Question: Which visualization type does this figure use?
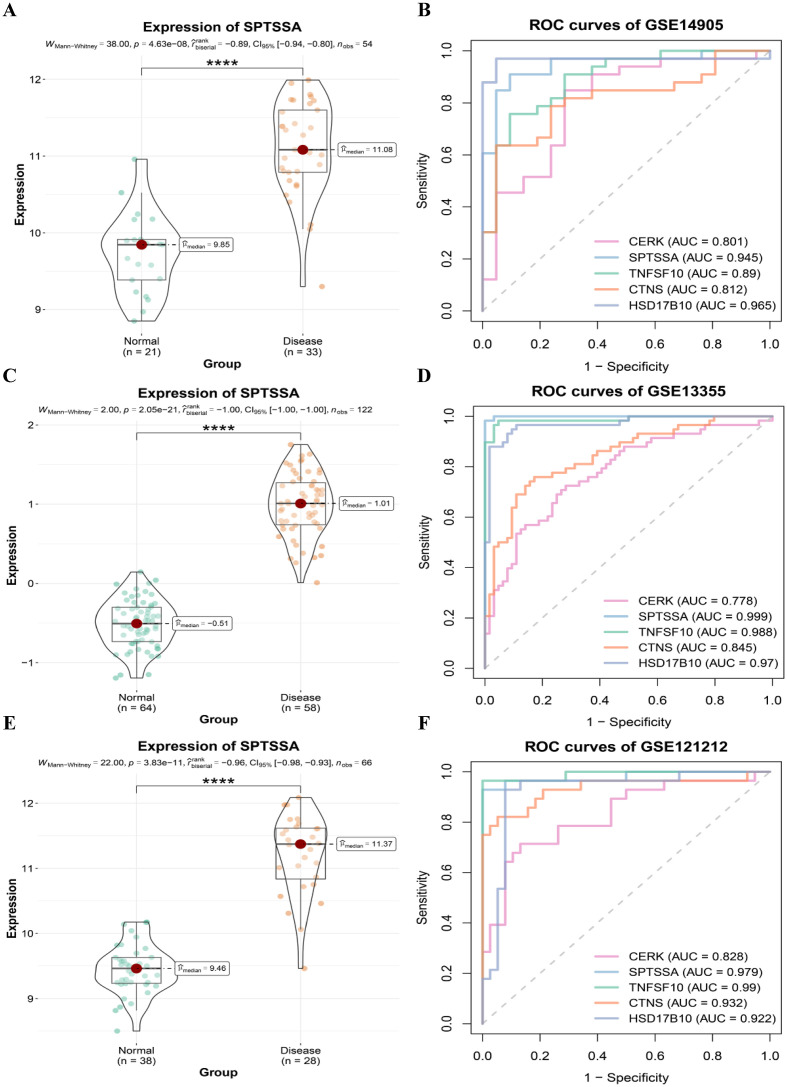
Answer: line